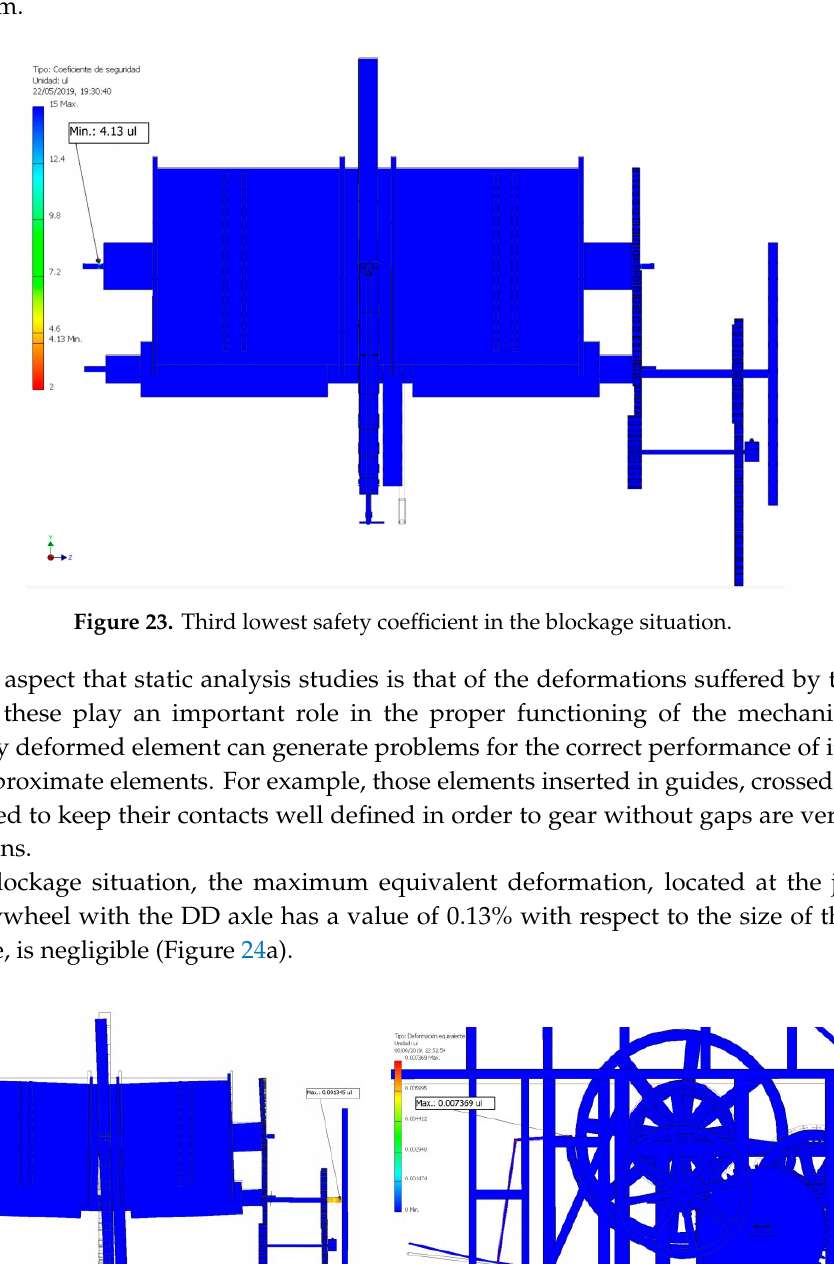
Figure 23. Third lowest safety coefficient in the blockage situation.